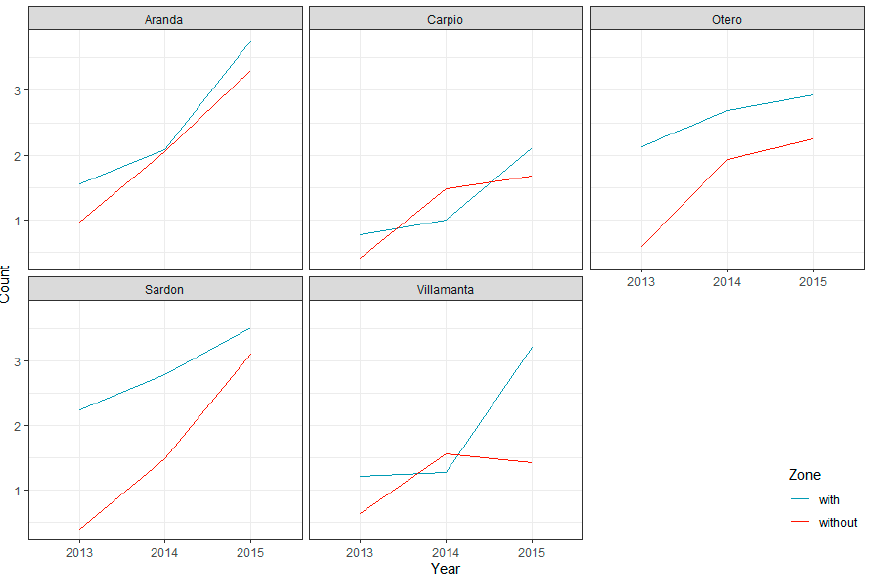
Figure 2. Plot of the means of the total number of insects between zones across the farms through the